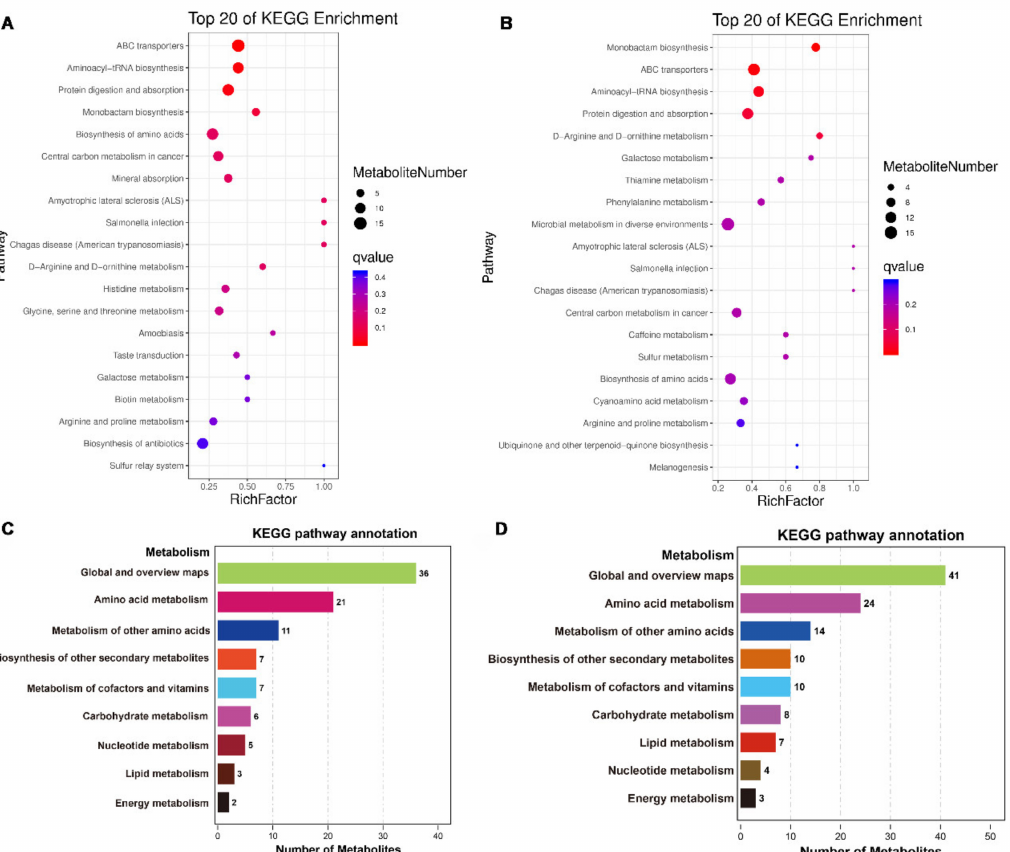
Figure 5. Diagram of metabolic pathways in hemolymph affected by BmNPV infection. ( A , B ) Top 20 KEGG-enriched pathways based on DE metabolites in the hemolymph of BmNPV-infected silkworm at 1 ( A ) and 3 dpi ( B ). The statistics of metabolites enriched in the KEGG class metabolism at 1 dpi ( C ) and 3 dpi ( D